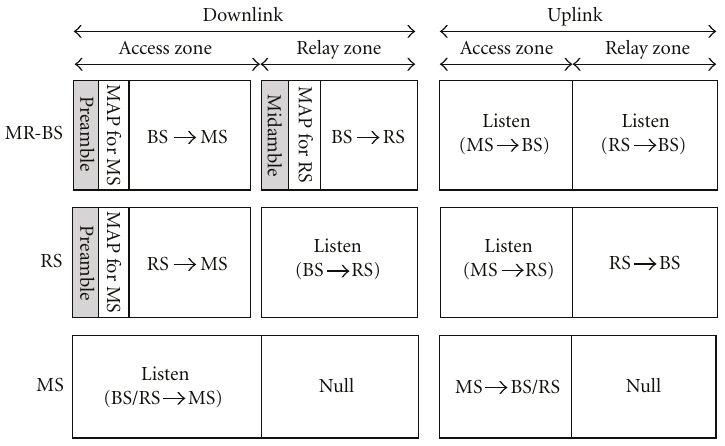
Figure 3: Frame structures for IEEE 802.16j MultiHop relay network